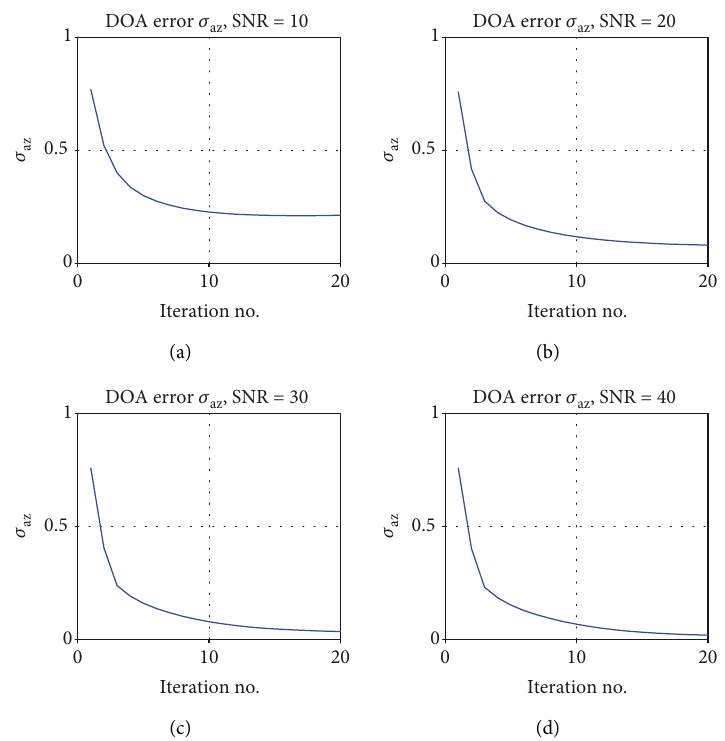
Figure 10: The DOA error 𝜎 in degrees as a function of the iteration number, for different signal-to-noise az